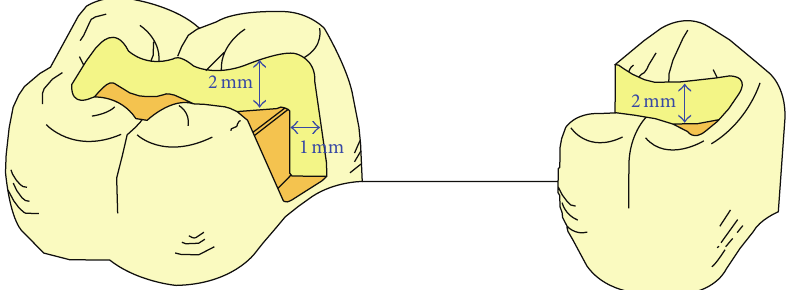
Figure 1: The ideal shape of the prepared cavities to receive the modified metal-ceramic IRFPD.